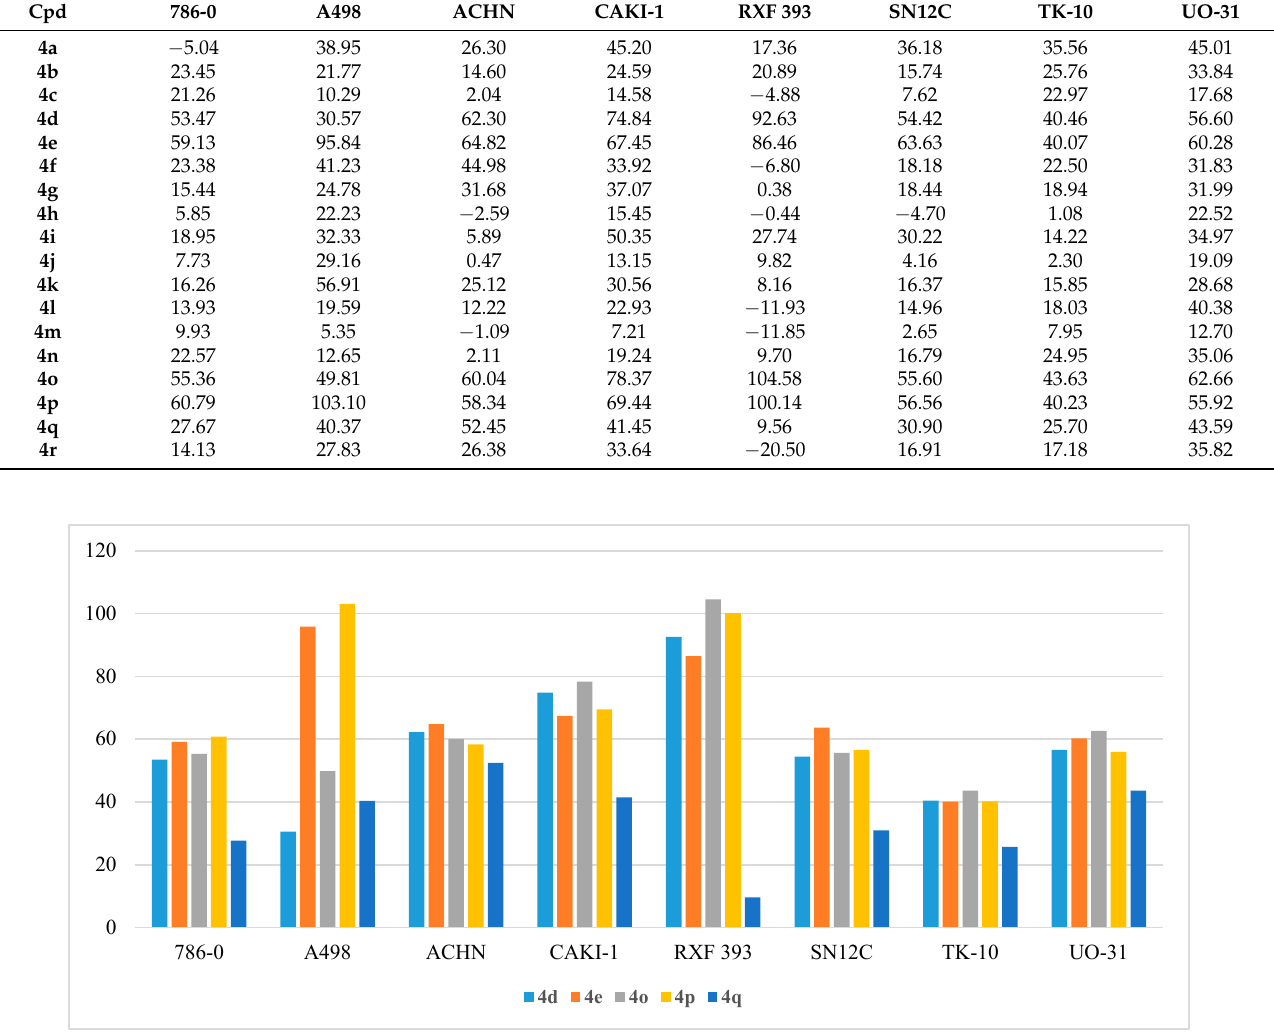
Figure 11. Anti-proliferative activities (% GI) of compounds 4d , 4e , 4o , 4p , and 4q against renal cancer cell lines. Anti-proliferative activity on prostate cancers: Two prostate cancer cell lines (PC-3 and DU-145) were used for the anti-proliferative evaluation of the target compounds 4a ‒ r (Table 12). Among the tested series, only com- pounds 4d , 4e , 4o , and 4p exhibited satisfactory potency against the two cell lines. The four candidates inhibited the growth of the PC-3 cell line by % GI of 83.31%, 75.41%, 88.90%, and 85.15%, respectively. However, the DU-145 cell line was inhibited by % GI of 80.87%, 78.17%, 77.35%, and 83.88% by the four compounds, respectively (Figure 12).